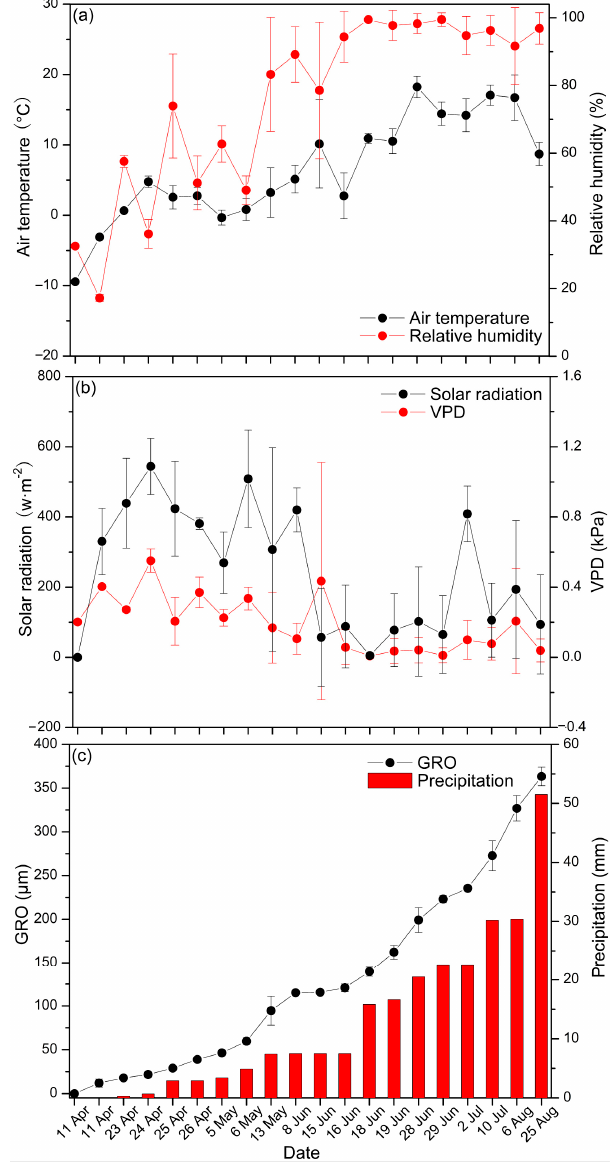
Figure 3. ( a ) Changes of mean air temperature, mean relative humidity, ( b ) mean solar radiation, mean vapour pressure deficit (VPD), ( c ) cumulative precipitation and growth-induced irreversible stem expansion (GRO) in each time period. Each time period of GRO change was made of statistics and each time period of change generating was counted.